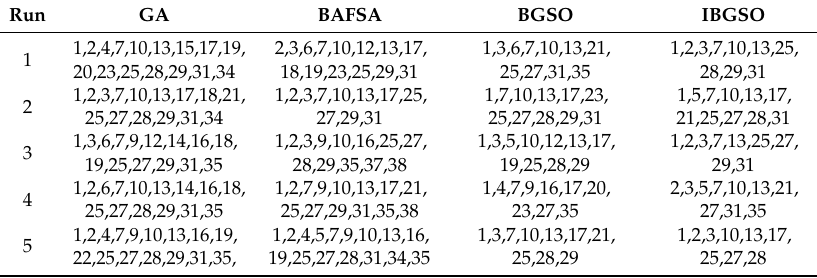
Table 5. Sensor selection results for subject 2 with five runs using the OPPORTUNITY dataset. Run GA BAFSA